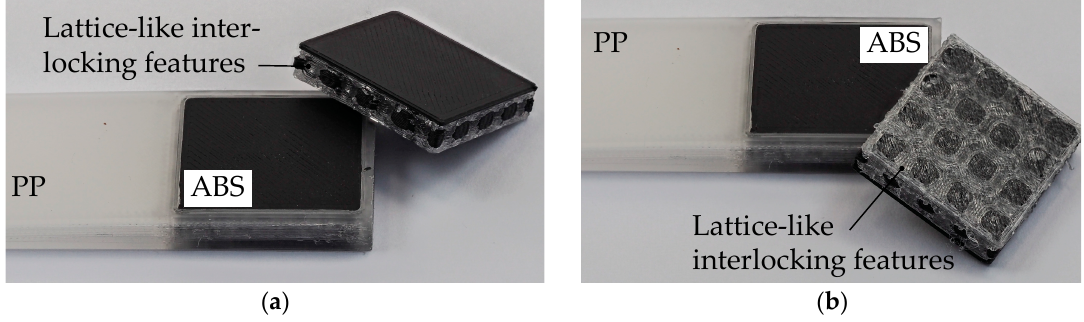
Figure 15. Side ( a ) and top view ( b ) of lattice-like interlocking features for combination of PP and ABS.